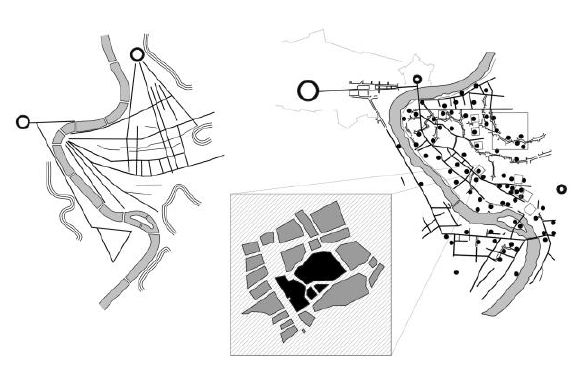
Figure 2. In the first scheme we can see how the polarities of the Vatican and Piazza del Popolo influenced the orientation of the routes.In the second scheme we can see how the Roman routes, in black, persist and orient the medieval fabric of the city. The medieval paths are grafted onto the ancient ones and they grant the new churches, schematized in circles, with the ancient traces. The Roman monumental complexes, black squares, become catalysing elements of the new religious buildings. In the zoom the study area is synthesized through a schematization of the Bufalini's map; 1551.